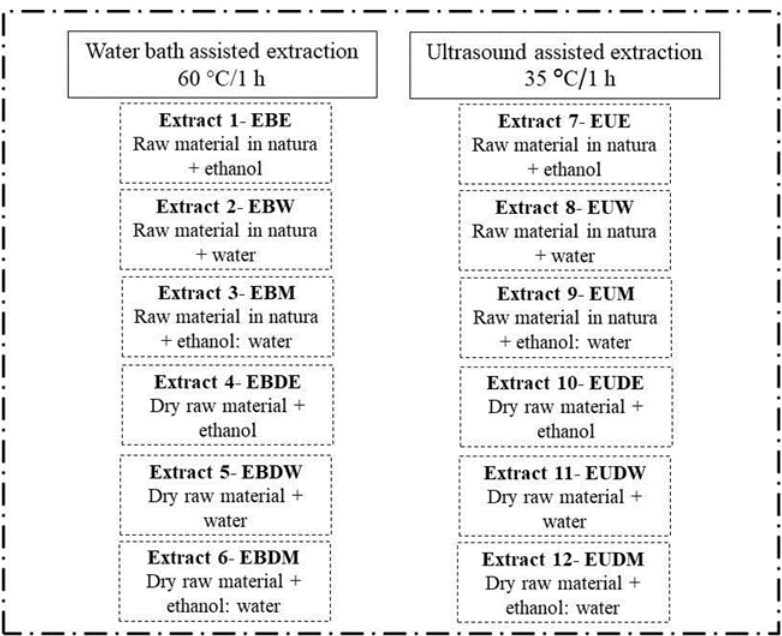
Figure 4. Representative scheme of extraction procedure.